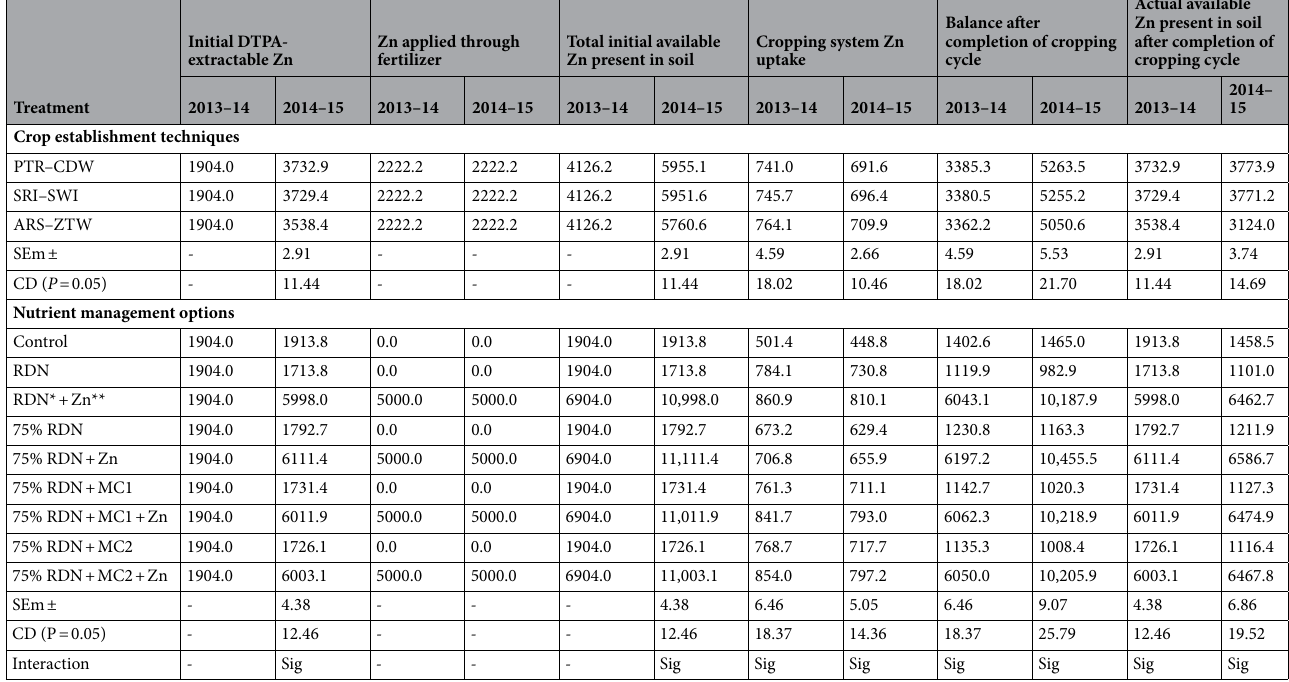
Table 13. Effect of crop establishment techniques and nutrient management options on zinc (Zn) (DTPA-extractable) (g ha –1 ) content in soil in RWCS. PTR , Puddled transplanted rice; SRI , System of rice